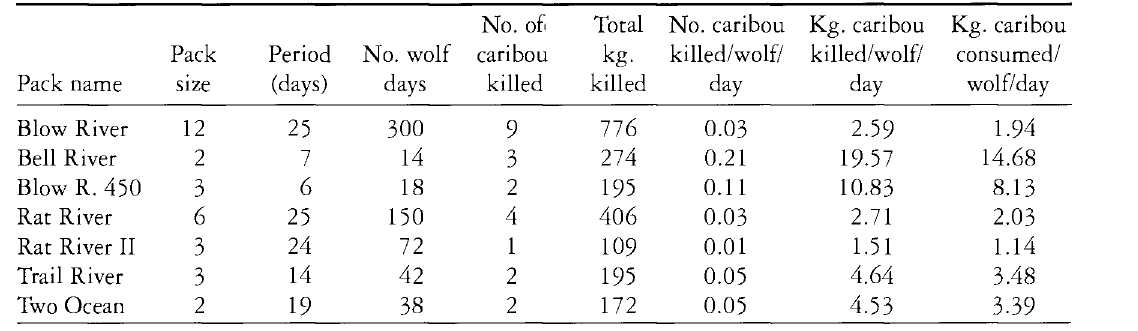
Table 1. Killing rates by wolves on caribou in our study, March and April 1989.